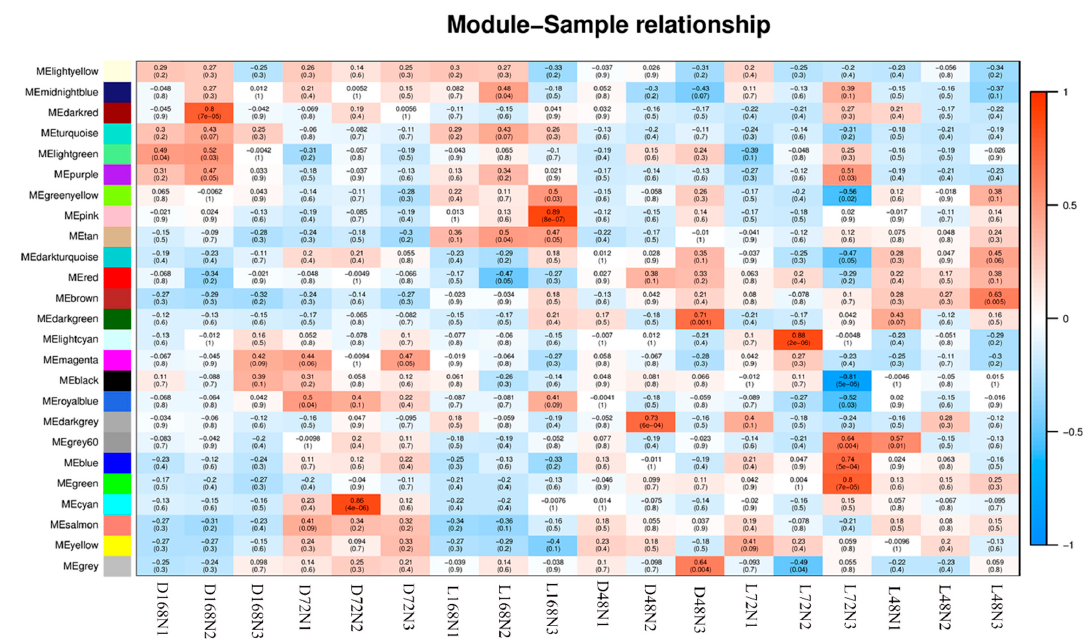
Figure 6. Heatmap of the sample and inter-module correlation. The abscissa is the sample and the ordinate is the module. The number of each grid represents the correlation between the module and the sample. The closer the value is to 1, the stronger the positive correlation between the module and the sample; The closer to -1, the stronger the negative correlation between the module and the sample. The numbers in brackets represent the significance p -value. The smaller the value, the stronger the significance. Table 3. KEGG analysis of sample-specific modules for different light treatments.